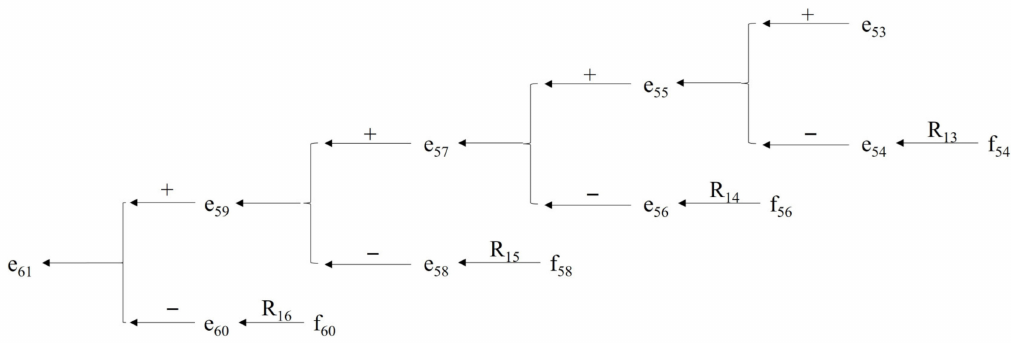
Figure 21. The variable relationship graph of the reactor.